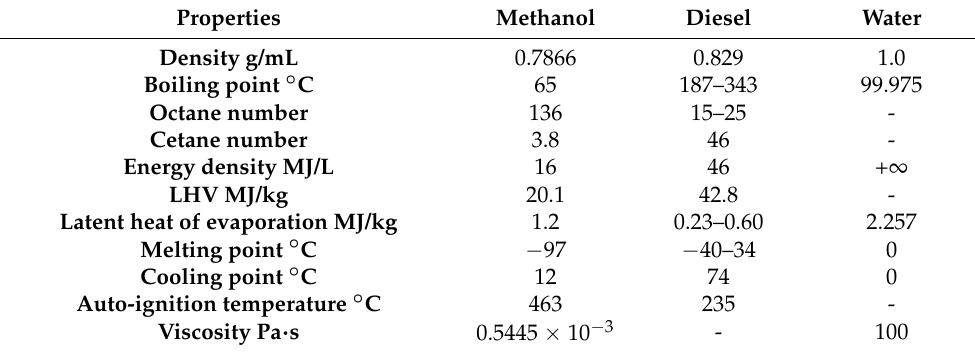
Table 2. Characteristics of diesel and methanol